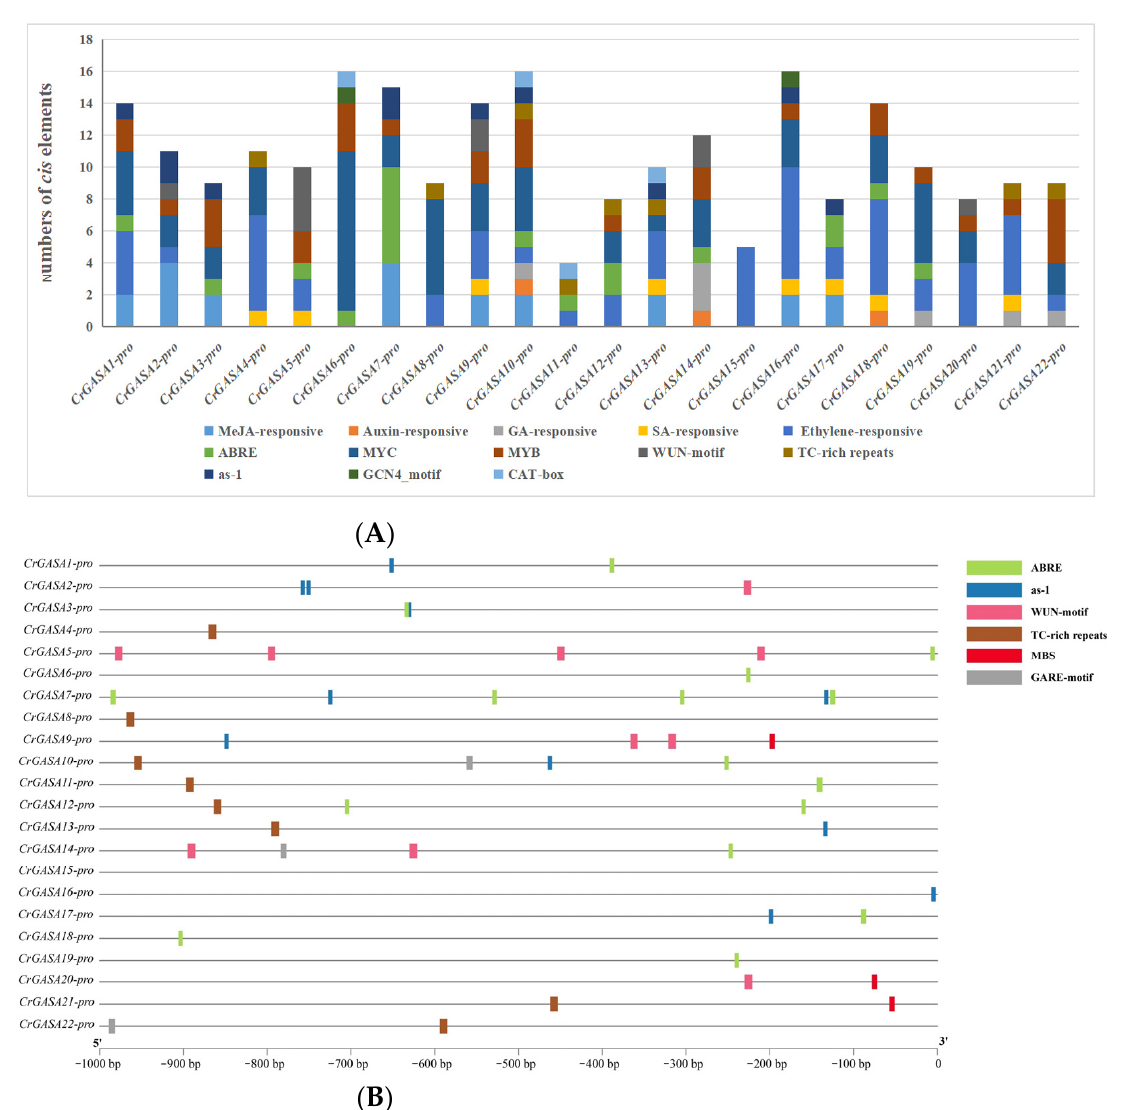
Figure 5. Statistics for predicted cis -regulatory elements in the CrGASA promoters (ATG upstream 1000). ( A ) Summaries of the thirteen cis -regulatory elements in the twenty-two CrGASA promoter regions. ( B ) Distribution of the six cis -regulatory elements (ABRE, as-1, WUN motif, TC-rich repeats, MBS, gibberellin-responsive motif, GARE) in the twenty-two CrGASA promoter regions. The elements are represented by different symbols. The scale bar represents 100 bp.